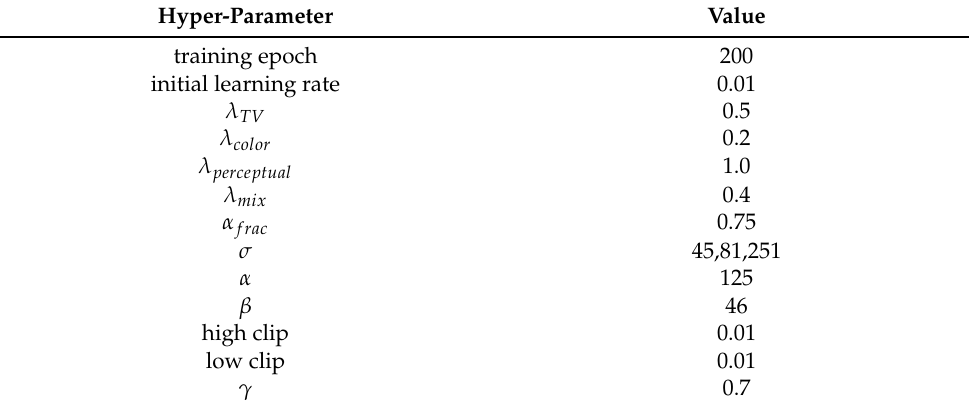
Table 1. Alterable hyper-parameters in the proposed